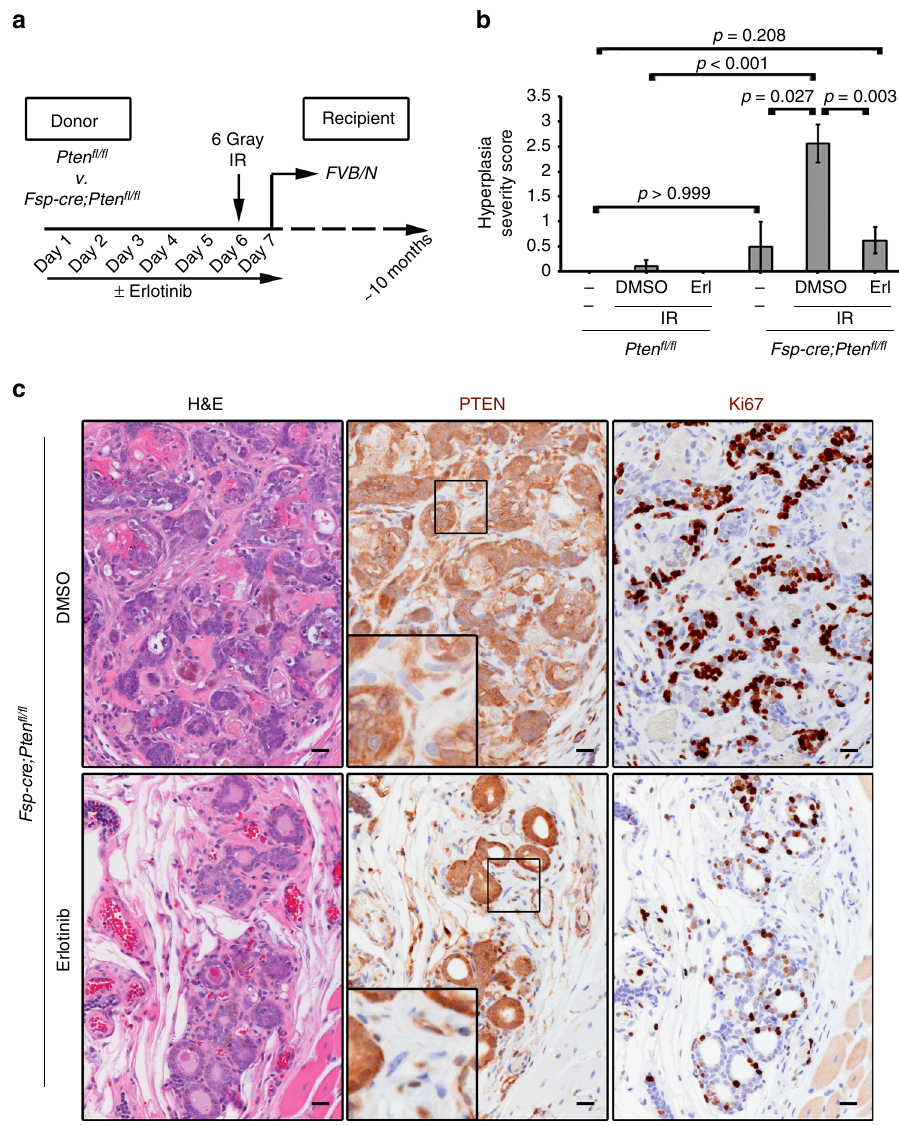
Fig. 6 A single dose of radiation causes mammary hyperplasia in stromal PTEN-null mammary tissue and this effect that is abrogated by EGFR